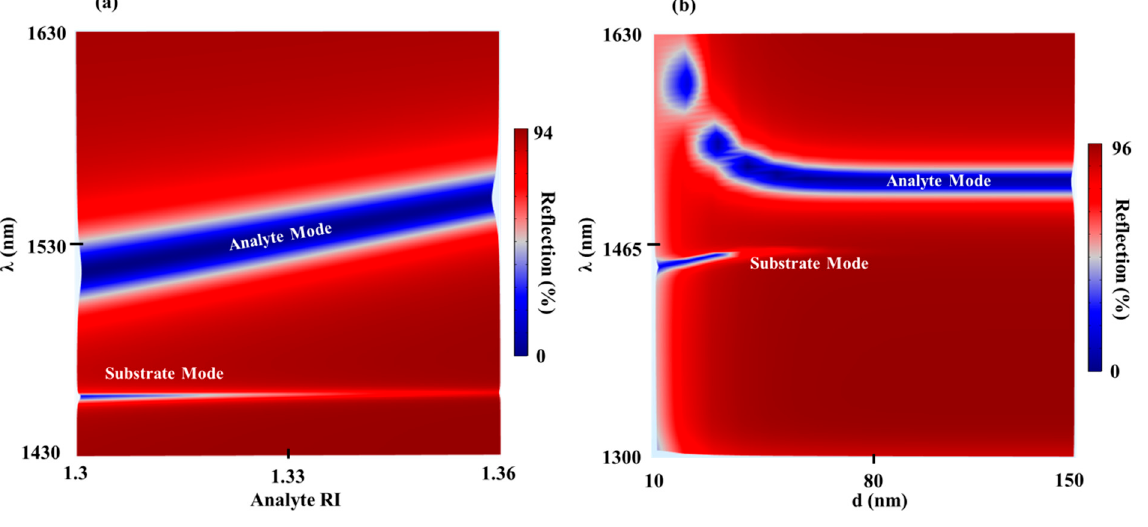
Figure 4. ( a ) Reflection analyte RI– λ map of the TDGTMF geometry for h = 175 nm and d = 40 nm. ( b ) Reflection d– λ map from the TDGTMF geometry, with h = 175 nm. TM polarized light under normal incidence was used in the simulations of the Si 3 N 4 grating with Λ = 1000 nm and FF = 0.55 in ( a , b ). Water and SiO 2 were used for the superstrate (analyte) and substrate, respectively.